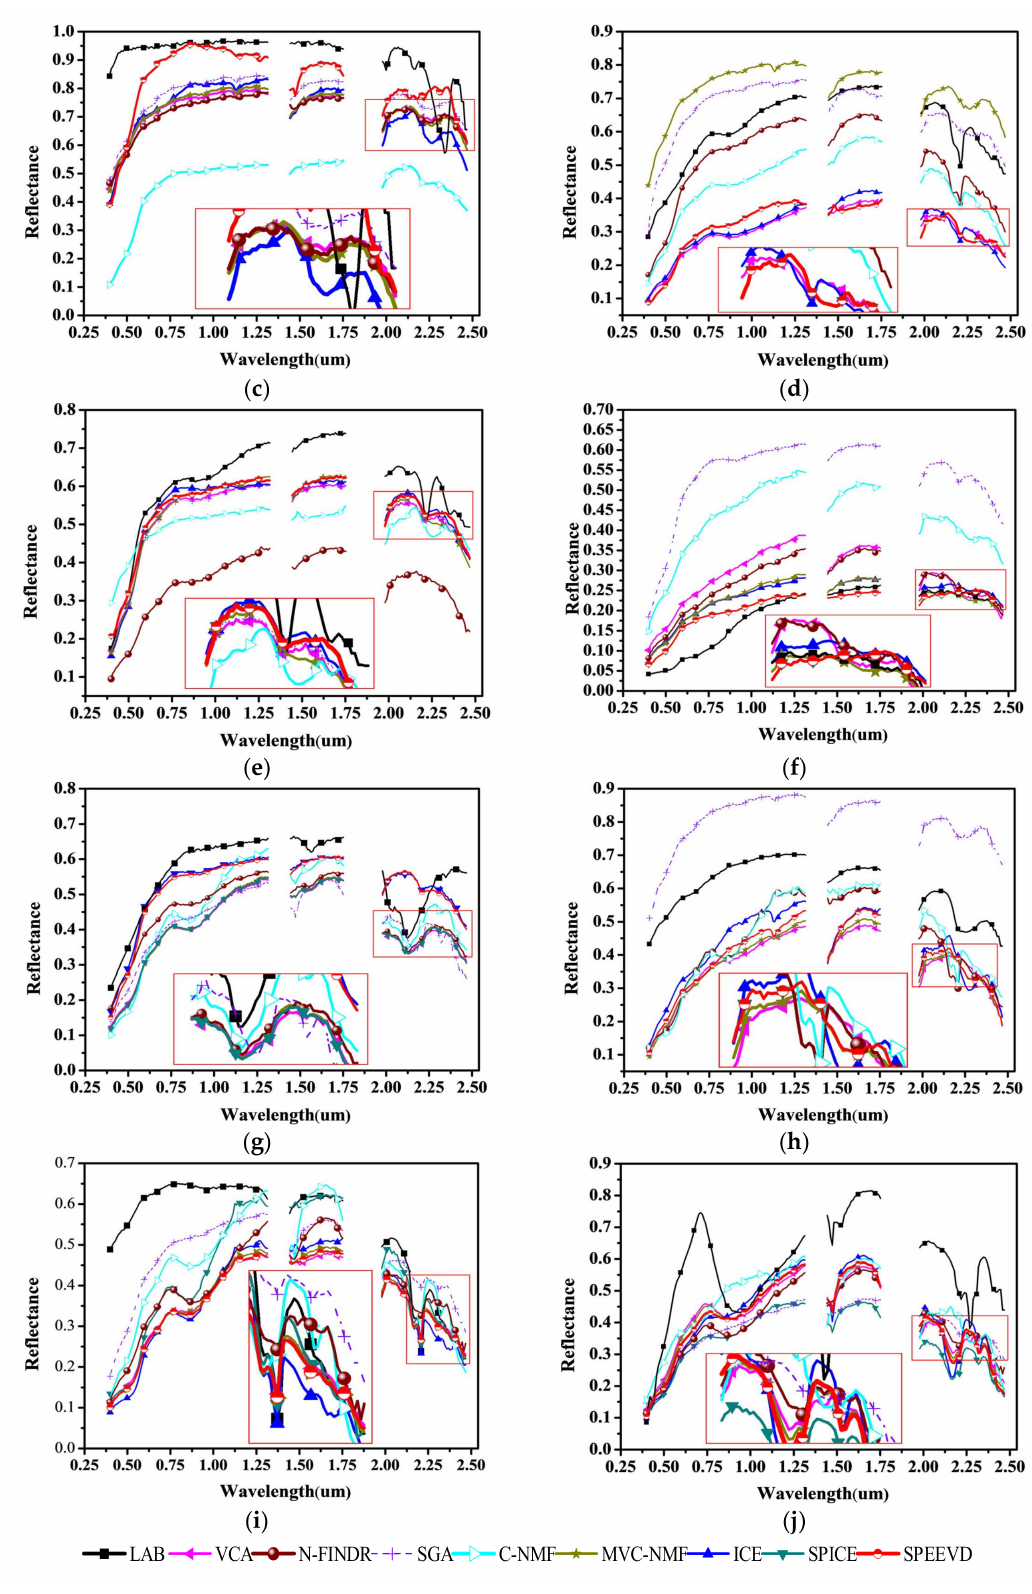
Figure 10. Endmember spectra with the different methods. ( a ) alunite ( b ) sphene ( c ) calcite ( d ) muscovite ( e ) montmorillonite ( f ) desert vanish ( g ) buddingtonite ( h ) chalcedony ( i ) kaolinite KGA ( j )